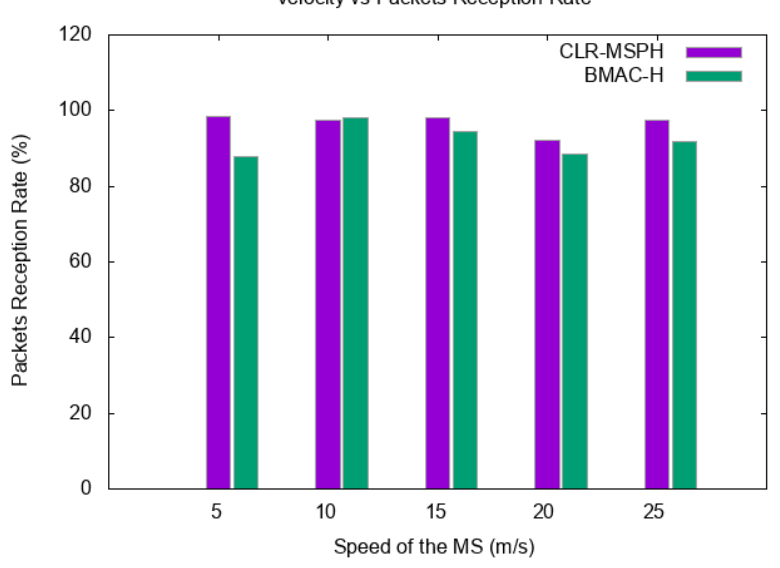
Figure 8. Packets Reception Rate VS the velocity of the MS in m/s. Table 2. Simulation results in terms of packets reception rate with varying the speed of the MS. The velocity of the MS in m/s.